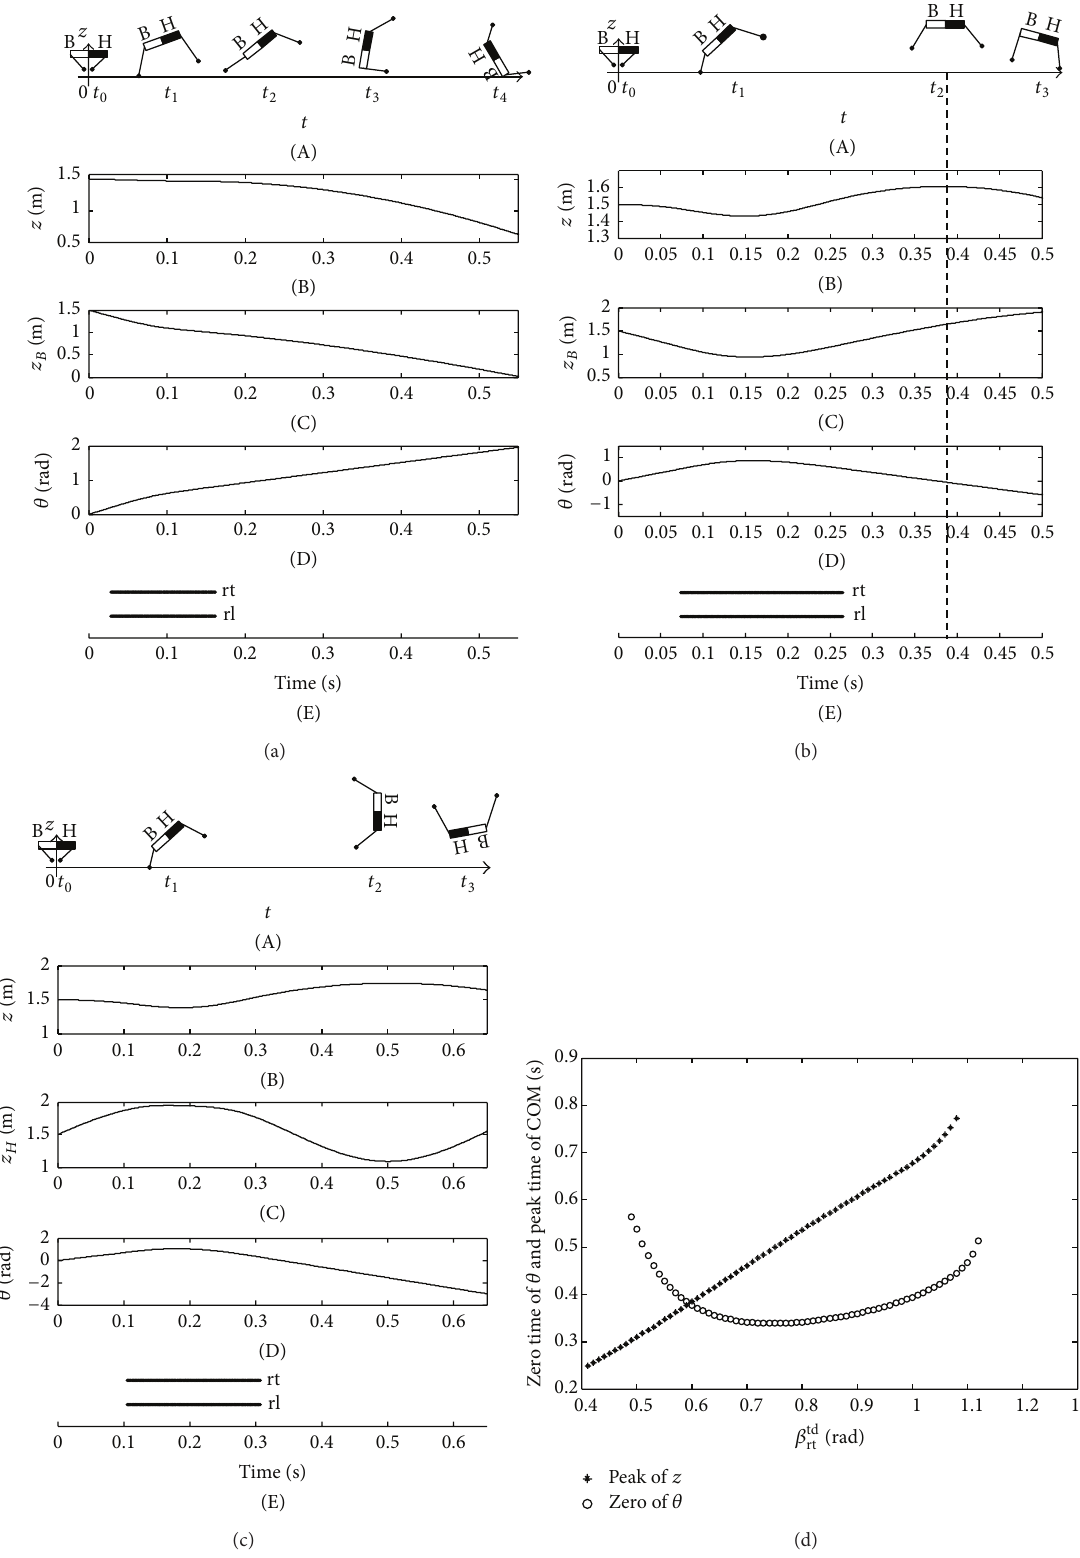
Figure 17: Imbalance and balance postures of racehorse. (a) The imbalance posture when 𝛽 td rt = 0 . 21 rad; (b) the balance posture when 𝛽 td = 0 . 60 rad; (c) the imbalance posture when 𝛽 td rt